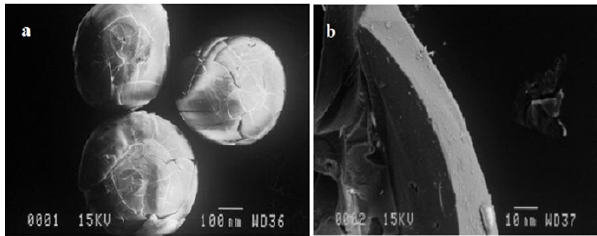
Fig.2 . SEM images of hollow γ-alumina nanosphere prepared in alkaline medium, a) after calcination at 650 o C for 3 hours; b) shell thickness image after breaking of nanosphere